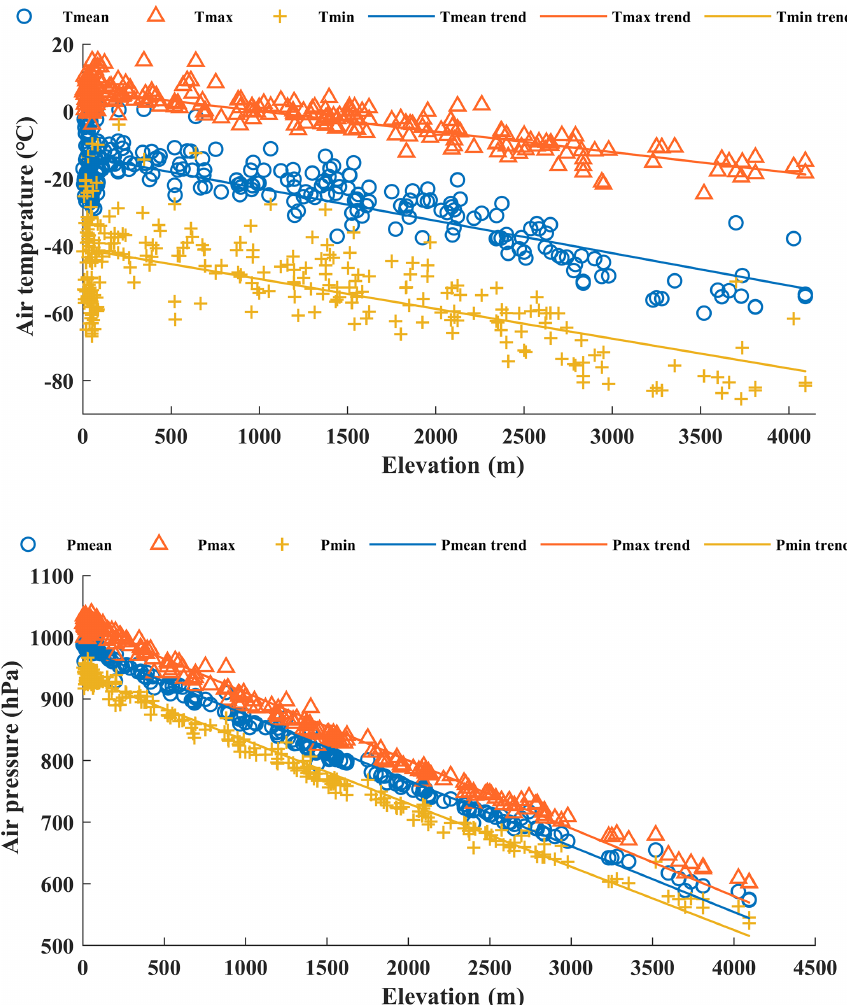
Figure 5. Multiyear 3h mean, maximum and minimum air temperature and pressure as a function of